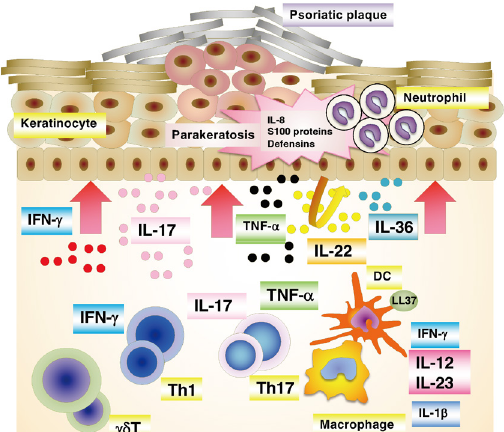
Figure 2. A schematic presentation of immunopathogenesis of psoriasis. At the psoriatic site, a cascade of events start with the activation of a variety of immune cells including keratinocytes. These activated cells secrete cytokines, which in turn activate myeloid DCs. DCs are central to provide a link between innate and adaptive immune responses. The activated myeloid DCs trigger differentiation into effector T cells (Th1 and Th17), leading to their migration into the skin tissue. The secreted mediators [e.g., IL-17 subunit alpha (IL-17A), IL-17F, IL-22 from Th17 cells, and IFN-γ and TNF-α from Th1 cells] then stimulate keratinocyte activation and proliferation, leading to plaque formation. Activated keratinocytes produce antimicrobial peptides and various chemokines that feedback into the proinflammatory cycle, resulting in the continued immunopathologic progression of